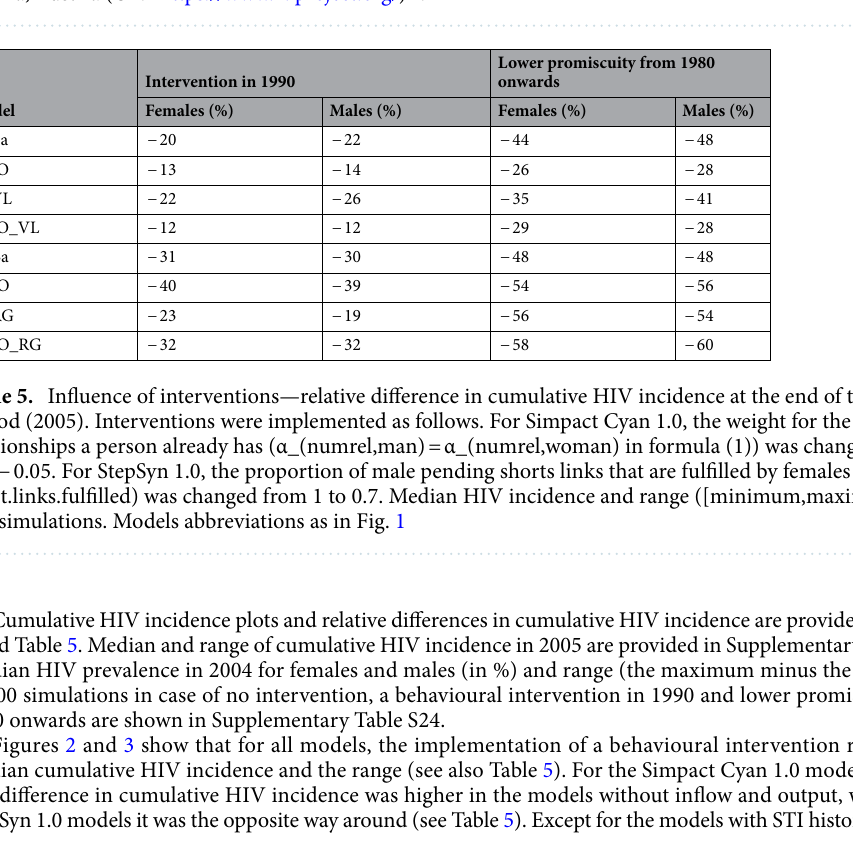
Figure 3. Cumulative incidence for HIV in males from 1980 to 2005. Median cumulative incidence of 100 simulations and the range ([minimum,maximum]) (shaded area). Red: no intervention implemented; blue: intervention implemented in 1990; green: lower promiscuity from 1980 onwards. Interventions were implemented as follows. For Simpact Cyan 1.0, the weight for the number of relationships a person already has (α_(numrel,man) = α_(numrel,woman) in formula (1)) was changed from 0 to − 0.05. For StepSyn 1.0, the proportion of male pending shorts links that are fulfilled by females (pending.short.links.fulfilled) was changed from 1 to 0.7. Model abbreviations as in Fig. 1. Figures were generated using R software version 3.6.0. (R Core Team (2019). R: A language and environment for statistical computing. R Foundation for Statistical Computing, Vienna, Austria (URL https:// www.R- proje ct. org/) 14 .